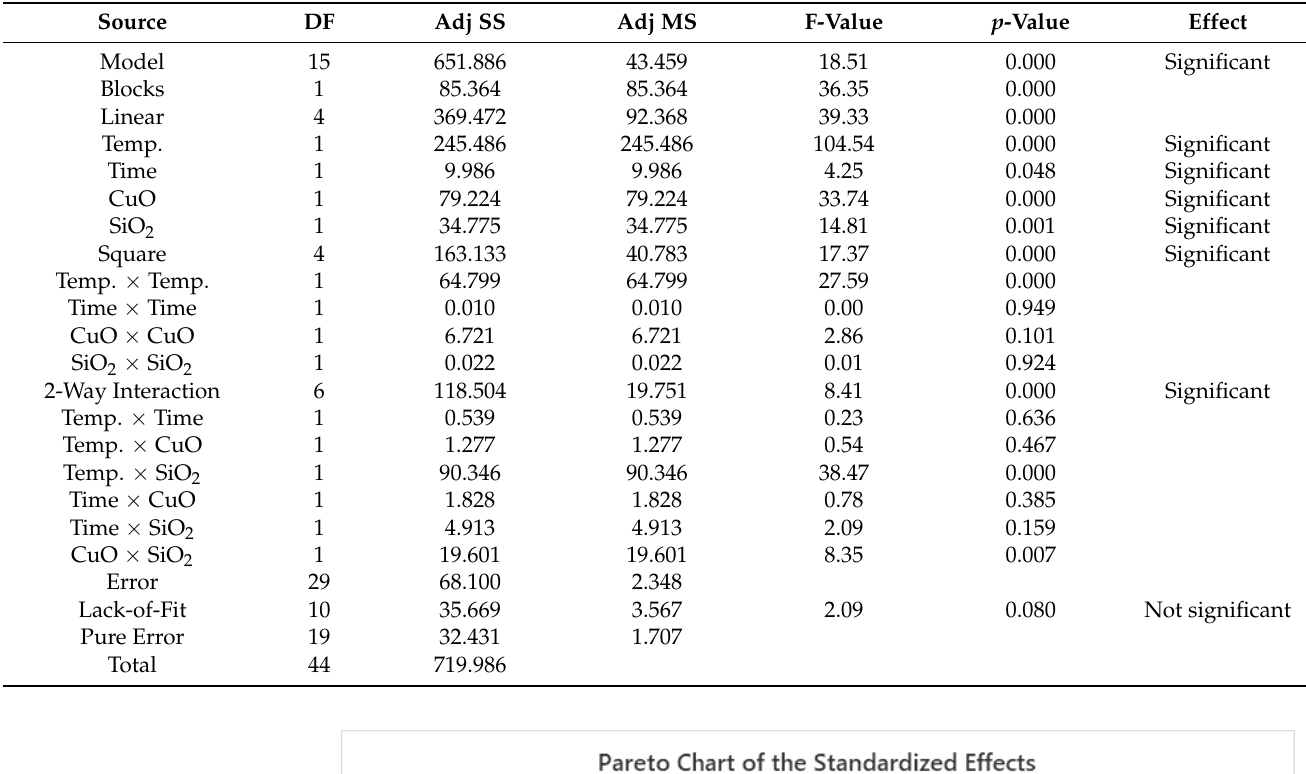
Table 7. The Microhardness Analysis of Variance by RSM.